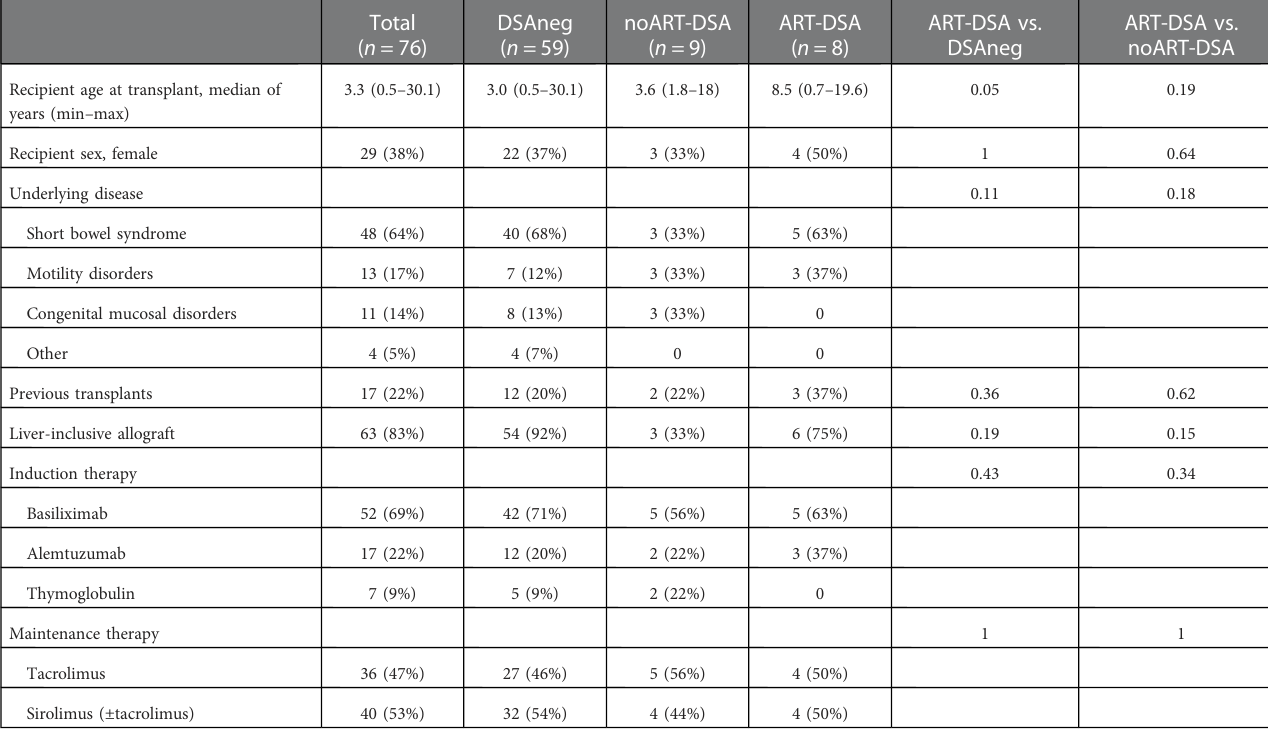
TABLE 1 Demographic and clinical characteristics of the fi nal studied cohort.